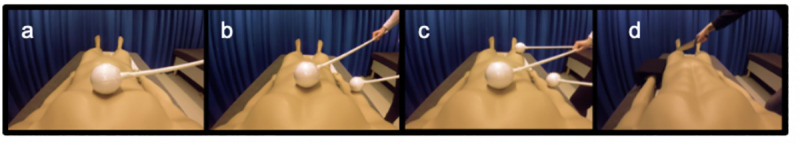
a-d. Visual stimulation. Display of an artificial mannequin’s body from the first-person perspective and the experimenter applying tactile stimulation to one (a), two (b), or three (c) body parts simultaneously. Visual stimulation was identical for both the synchronous and asynchronous conditions, the difference being the timing of the strokes applied to the participant’s real body. The participant lay on a bed with their head tilted forward and observed these videos through a head-mounted displays (HMD). Panel d displays the final scene comprising the knife in the SCR and illusion onset data collection (which was included for only the 1S, 3S, and 3A conditions; a still image of the mannequin’s body was instead presented at the end of the 1A, 2A and 2S conditions). Note. The presented images appear askew because they are monocular for illustrative purposes; a 3D binocular view (not askew) is achieved only within the HMD.